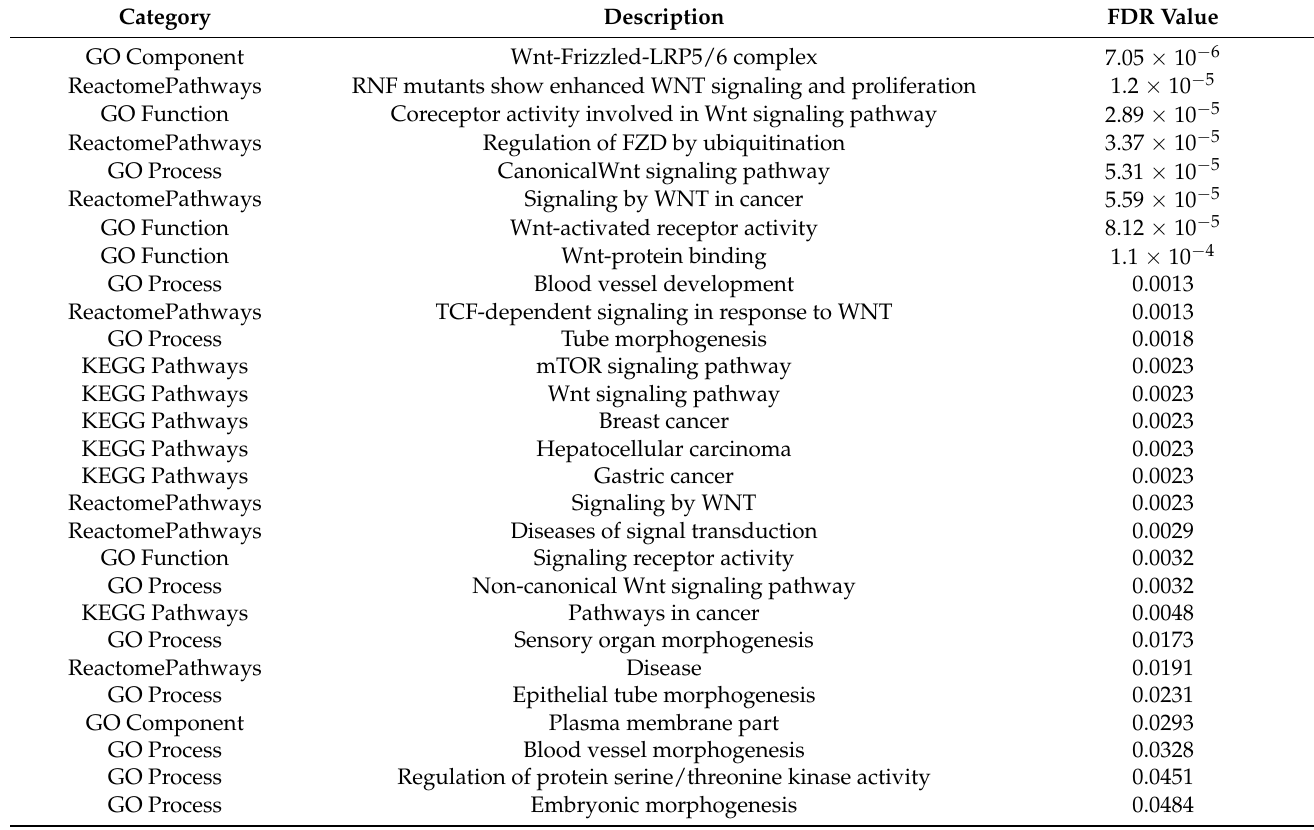
Table 5. Functional enrichment of the third subcluster of the PPI